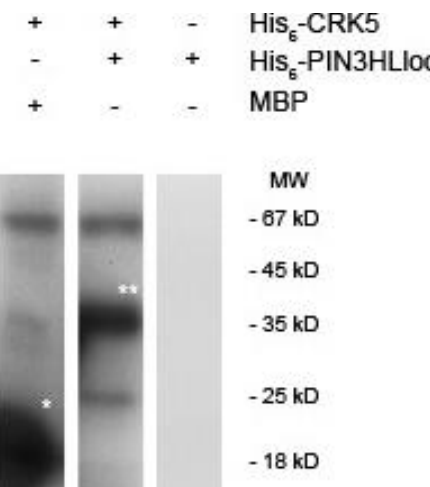
Figure 7. AtCRK5 phosphorylates PIN3 hydrophilic loops in vitro. In vitro phosphorylation assay with His6-AtCRK5 and two substrates: His6-PIN3HLloop and myelin basic protein (MBP) which was used as positive control. White asterisks indicate the phosphorylated MBP and His6-PIN3HLloop proteins, respectively.